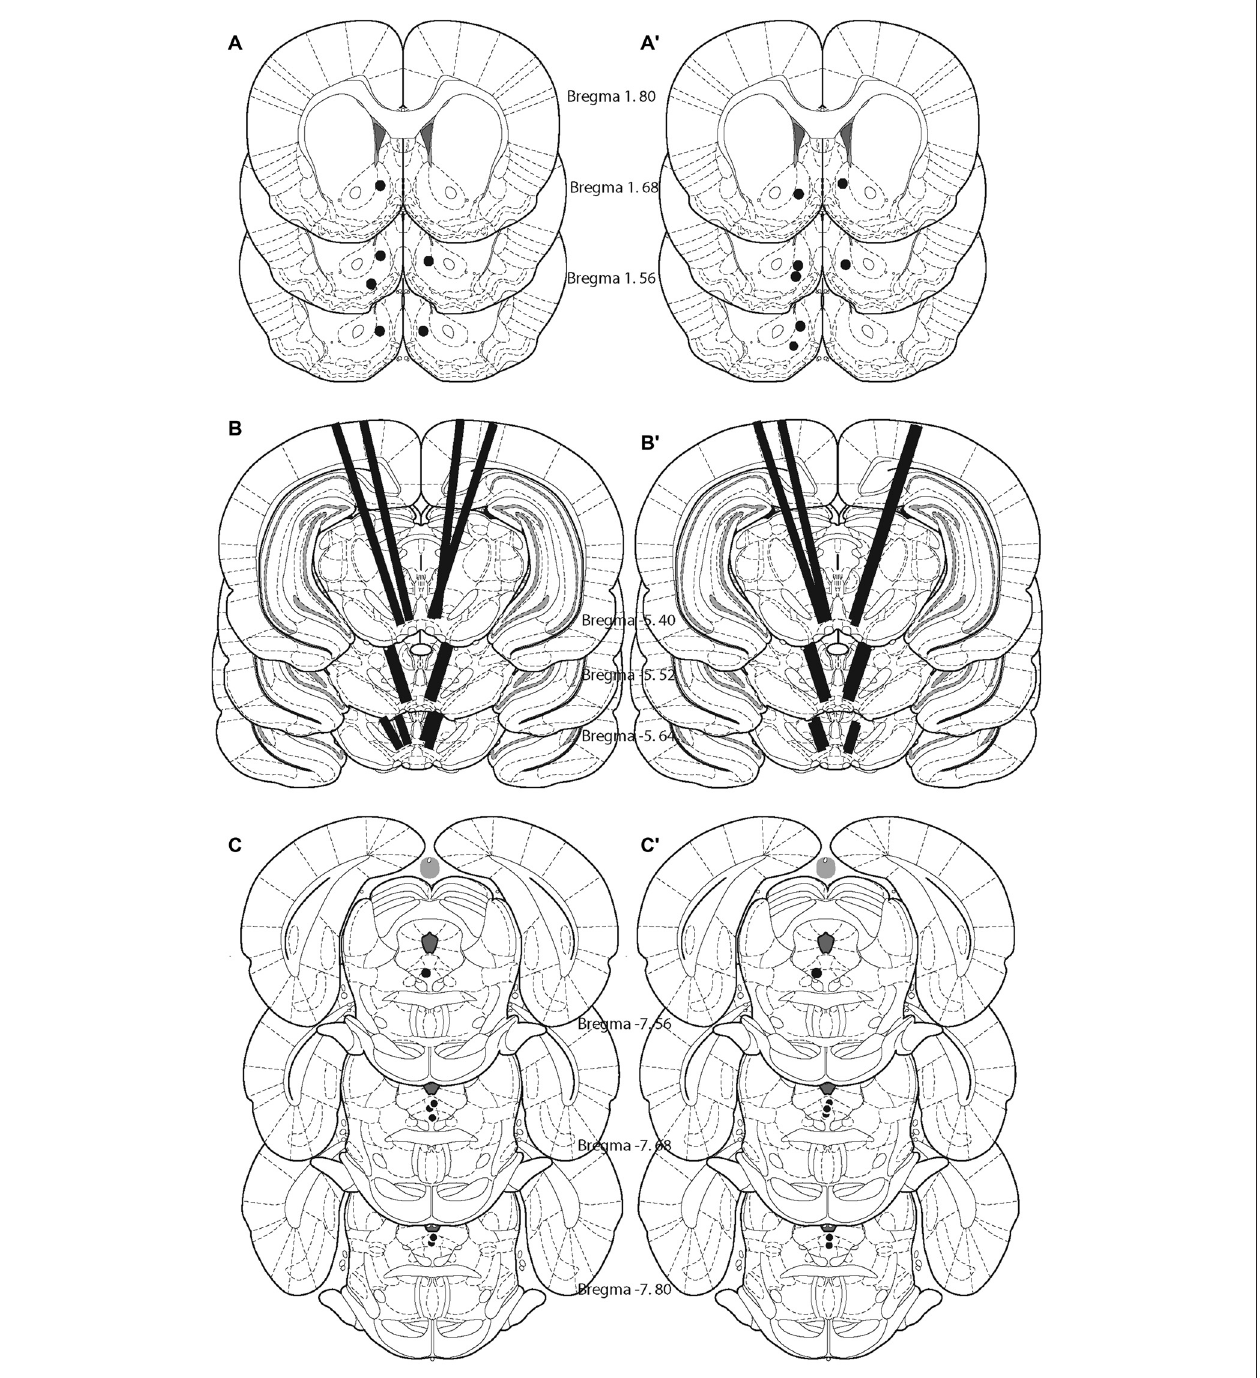
FIGURE 2 | Location of the tips of the carbon fibers (fast-scan cyclic voltammetry, FSCV; A,A (cid:48) ), injection sites (B,B (cid:48) ), and stimulating electrodes (C,C (cid:48) ) for each animal included in the study. Left panel shows the animals that were behaviorally trained. Right panel shows naïve animals.